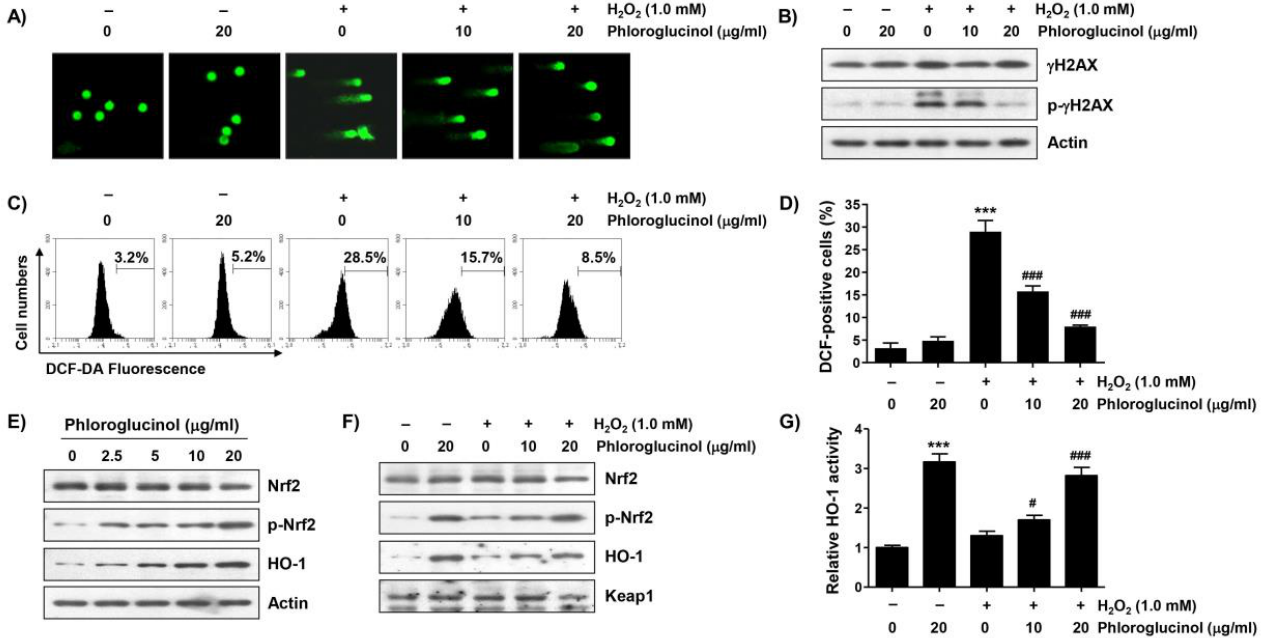
Figure 4. Phloroglucinol attenuates H 2 O 2 -induced DNA damage and ROS production and activates nuclear factor-erythroid-2 related factor 2 (Nrf2) in C2C12 myoblasts. Cells exposed with or without phloroglucinol for 1 h were stimulated with H 2 O 2 for another 24 h ( A , B , F , G ) or 1 h ( C , D ) or cells were incubated for 24 h in a medium containing the indicated concentrations of phloroglucinol ( E ). Cells were exposed to vehicle for control group. ( A ) Representative images following comet assay are shown (400 × ). ( B ) Changes in expression of γ H2AX and its phosphorylated form (p- γ H2AX) were determined by immunoblotting. ( C , D ) The levels of ROS production were investigated by performing 2′ , 7′ -dichlorofluorescein diacetate (DCF-DA) staining, and representative histograms ( C ) and results ( D ) of flow cytometry are presented. ( E , F ) After extracting cell lysate for each treatment group, expression levels of presented proteins were investigated through immunoblotting. ( G ) The activity of heme oxygenase-1 (HO-1) is presented as a relative value. Statistical difference was determined by Student’s t -test (*** p ˂ 0.001 vs. control group; # p ˂ 0.05 and ### p ˂ 0.001 vs. H 2 O 2 -treated cells).